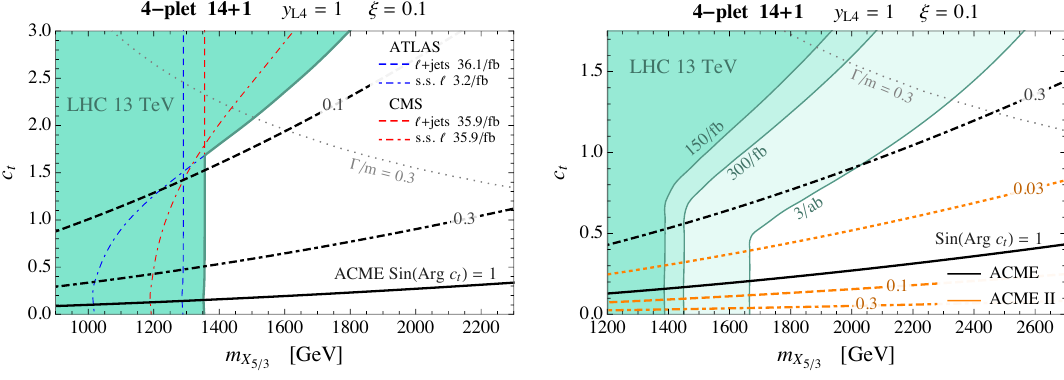
Figure 7 . Bounds on the c t coupling as a function of the mass of the X 5 = 3 resonance for the scenario with a light fourplet in the 14 + 1 model (for the choice (cid:24) = 0 : 1 and y L 4 = 1). The current bounds from the LHC data and from the constraints on the electron EDM are shown in the left panel, whereas the projections for the future LHC runs and the estimate of the future ACME II constraints are shown in the right panel. In the left panel we also show separately the direct bounds from the lepton plus jets (dashed lines) and for the same-sign dilepton analyses (dot-dashed lines) for ATLAS (blue) and CMS (red). The bound from the electron EDM current (black lines) and improved ACME II searches (orange lines) are shown for di(cid:11)erent choices of the complex phase of c t (sin(Arg c t ) = 1 ; 0 : 3 ; 0 : 1 ; 0 : 03 for the solid, dashed, dot-dashed and dotted lines respectively).